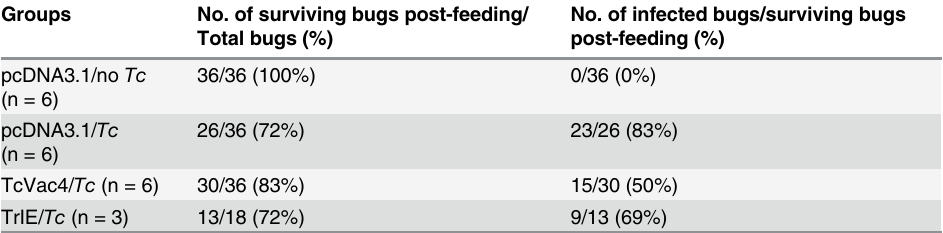
No. of infected bugs/surviving bugs post-feeding (%)